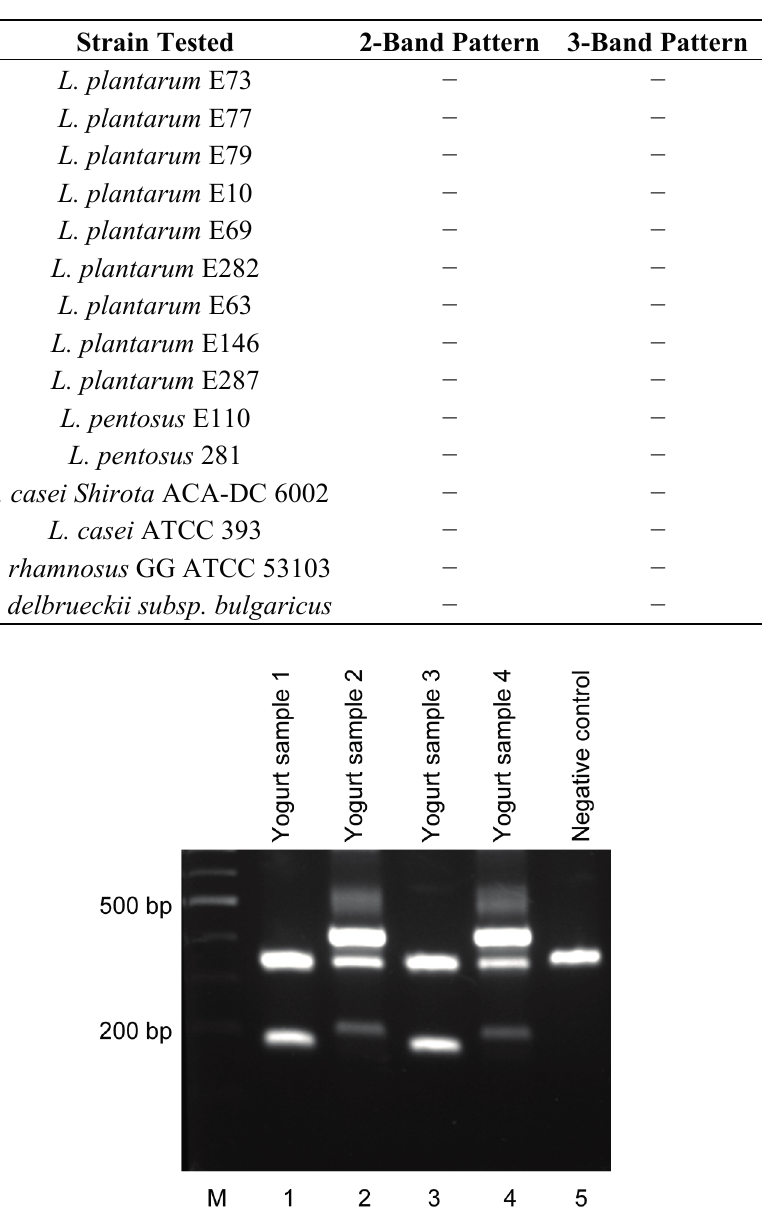
Figure 4. Molecular identification of L. plantarum 2035 or L. plantarum ACA-DC 2640